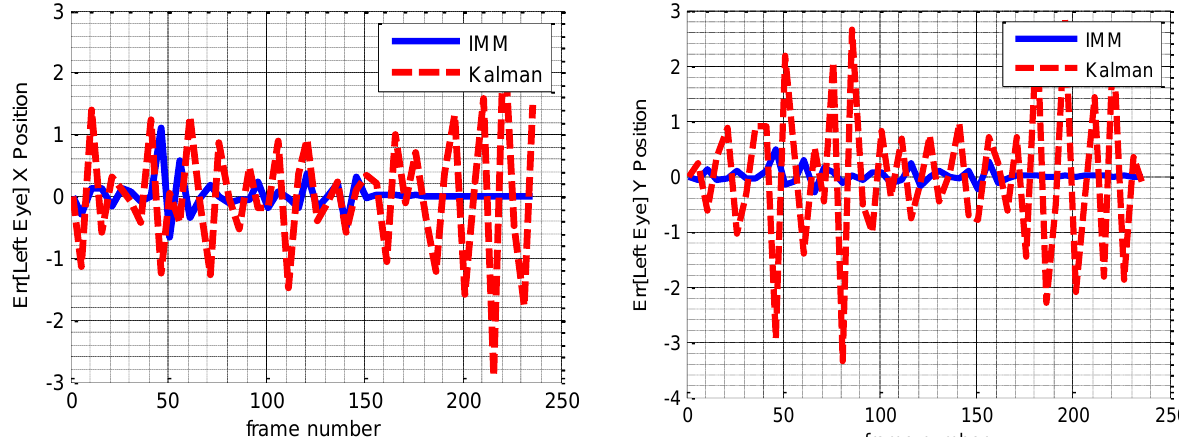
Figure 13. The error of left eye estimation of